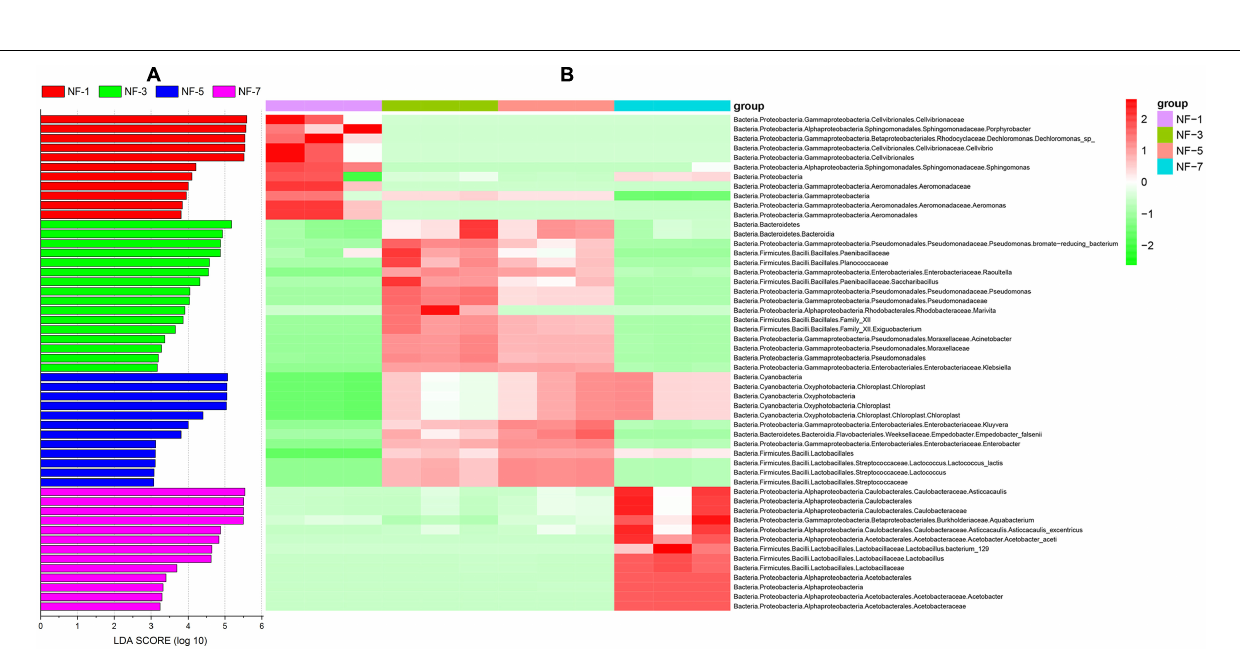
Frontiers in Microbiology |